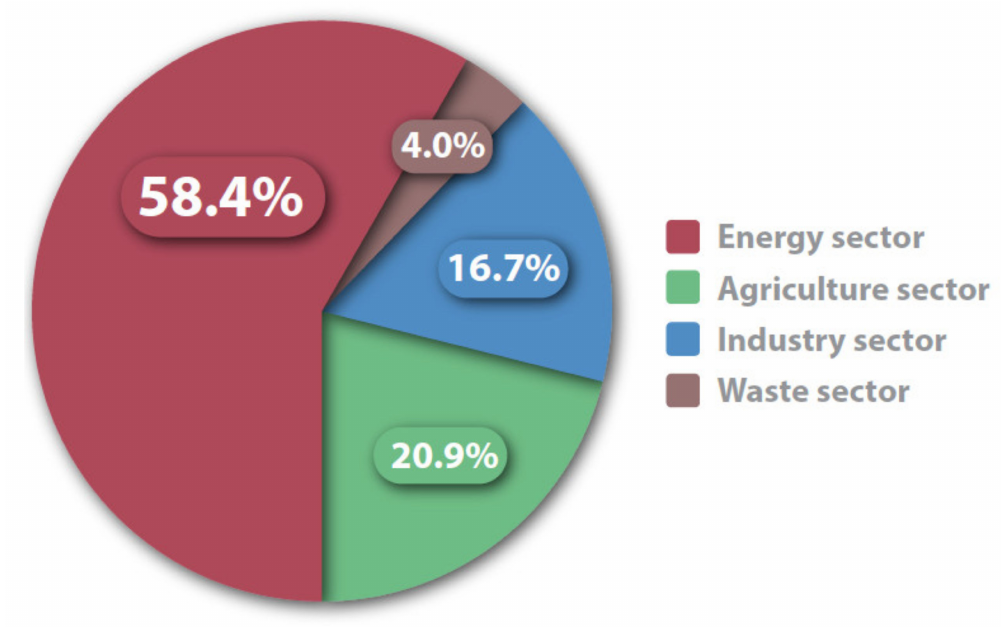
Figure 10. Lithuanian greenhouse gas emissions by economic sector in 2019. Past statistics show that between 1990 and 2000, GHG emissions fell sharply as a result of declining industrial production (Figure